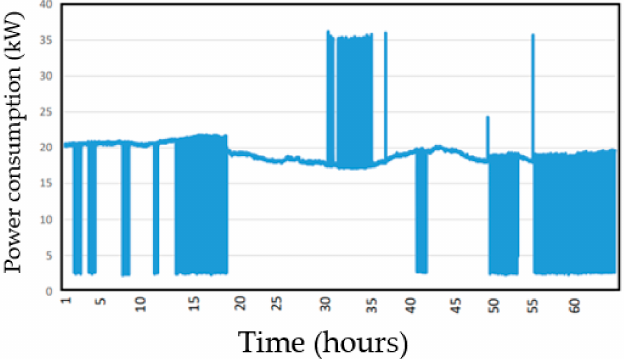
Figure 8. Power consumption of the third heat pump without auxiliary cooling subsystem in